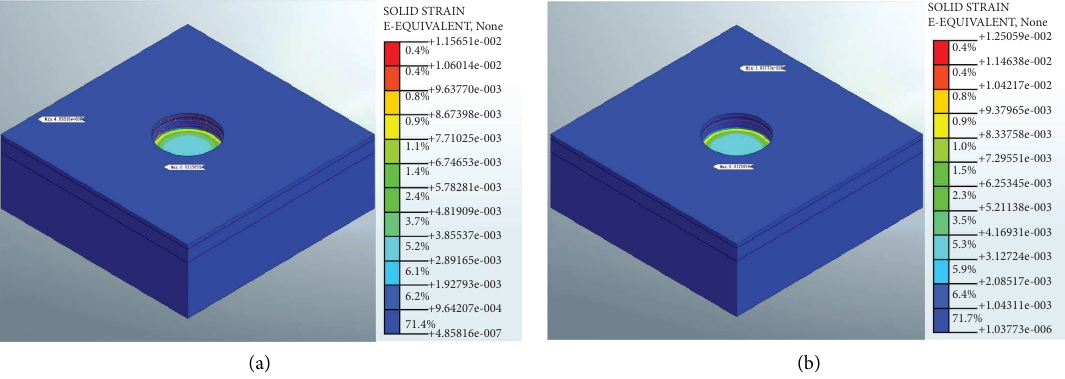
Figure 16: Working condition 7. Equivalent soil strain (a) without pore water pressure and (b) with pore water pressure